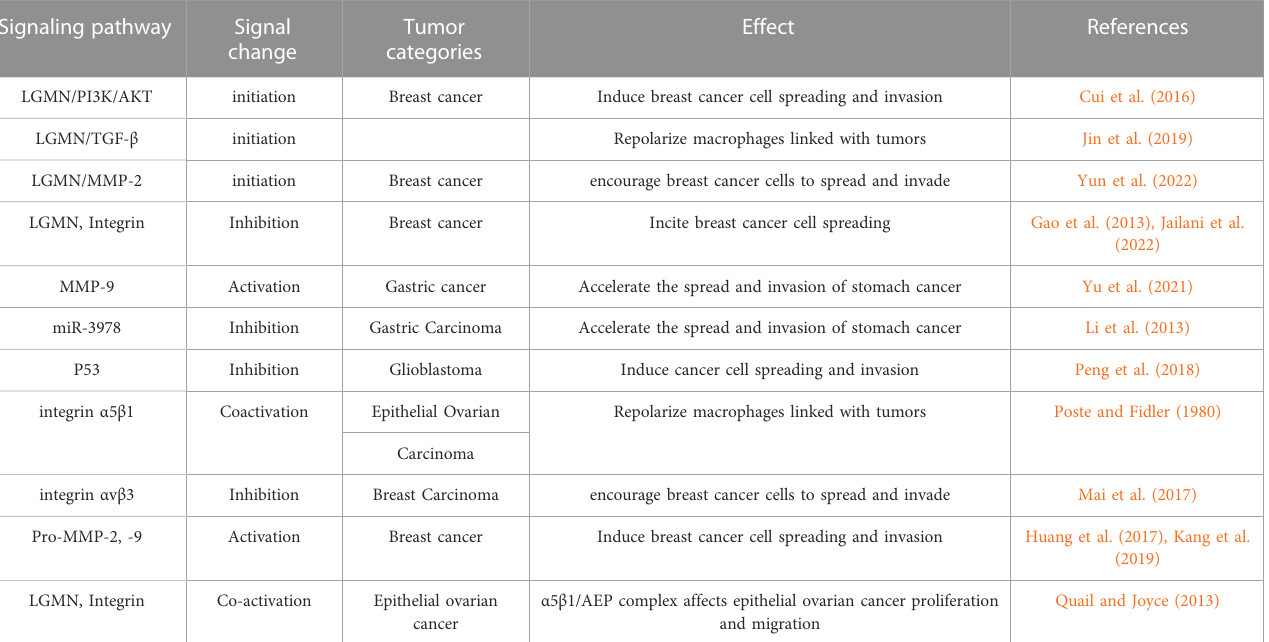
TABLE 1 Mechanism of LGMN in tumor formation and